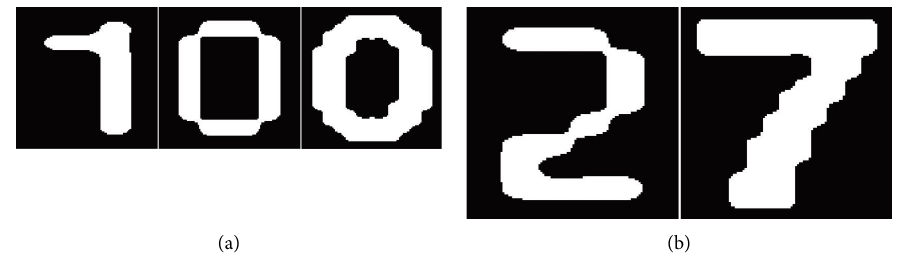
Figure 6: Te input samples: (a) test sample and (b) image sample